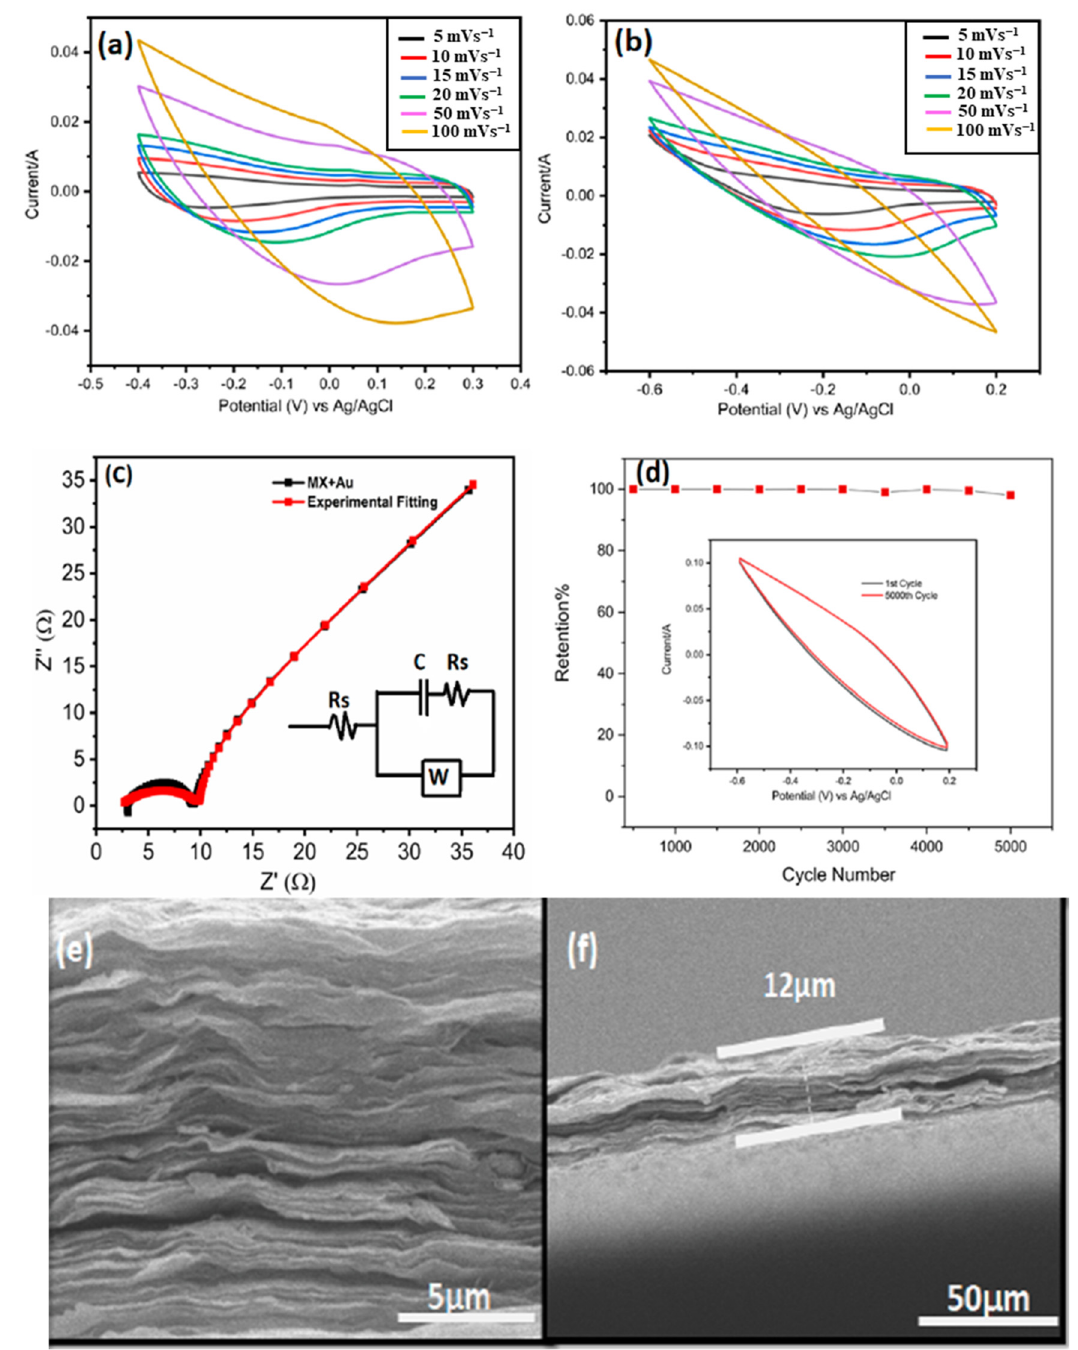
Figure 13. ( a ) CV curves of MXene at different scan rates in 3-electrode setup; ( b ) CV curves of MX/AuNPs in 1 M H 2 SO 4 at different scan rates in 3-electrode setup; ( c ) Nyquist plots of MX/AuNPs with inset showing the equivalent circuit model for the Nyquist plots; ( d ) MX/AuNPs electrode showing excellent cyclic stability with 98% capacitance retention at 100 mV s − 1 1M H 2 SO 4 after 5000 cycles; ( e ) cross-sectional image of the MX/AuNPs composite film demonstrating stacked layered structure; ( f ) cross-sectional image showing the thickness of the composite film [84].